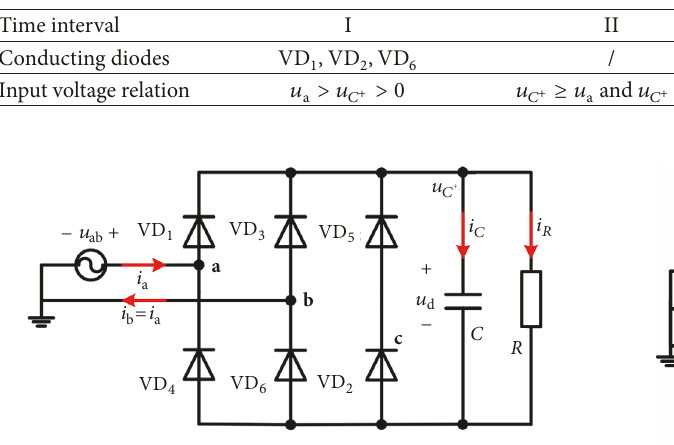
Table 4: Conduction situations of six diodes.